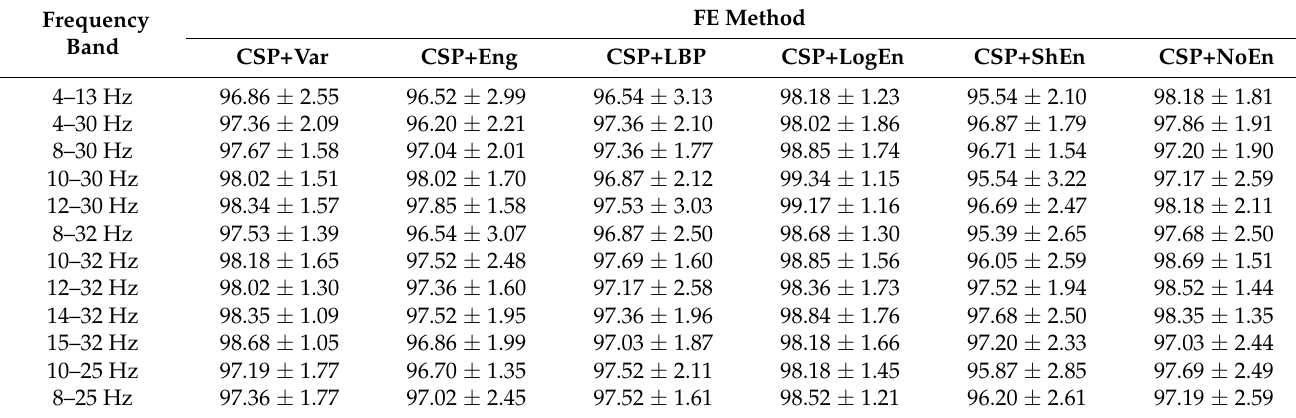
Table 6. Effect of frequency bands on classification accuracy using KNN (off–PD vs. HC).